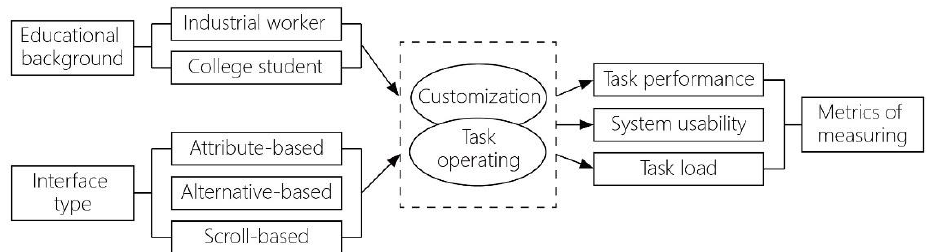
Figure 3. The research model of this study.